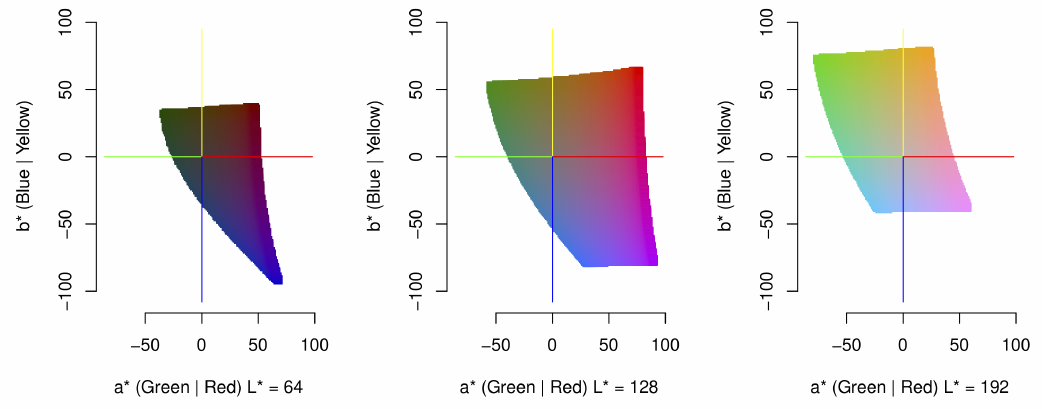
Figure 3. RGB to L ∗ a ∗ b ∗ colour space luminosity intersections—Varying degrees of luminosity (different L ∗ value) do not affect the identification of green-space (upper-left